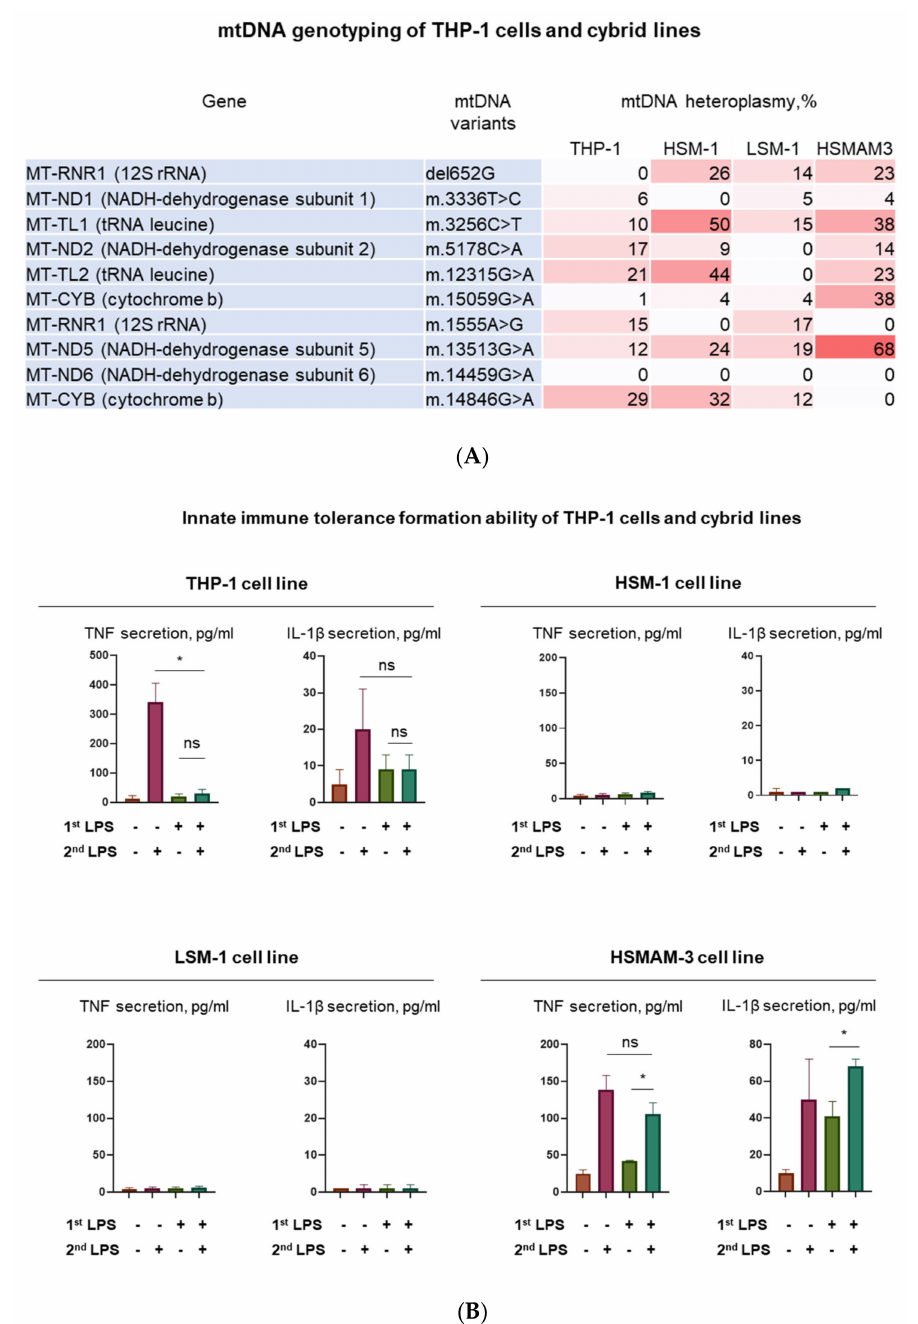
Figure 9. Ability of THP-1 cells and cybrid lines to form innate immune tolerance. ( A ) MtDNA genotyping of THP-1 cells and cybrid lines was performed and mtDNA heteroplasmy index was measured for 10 mtDNA mutations. ( B ) Innate immune tolerance formation ability of THP-1 cells and cybrid lines. First, 1 µ g / mL of lipopolysaccharides (LPS) was added to the cells cultured in suspension in RPMI medium (10% FBS) for 16 h (1st LPS). Then, cells were washed by sterile PBS and fresh RPMI medium with or without 1 µ g / mL of LPS was added for 4 h (2nd LPS). Finally, the secretion of tumor necrosis factor (TNF) and IL-1 β was evaluated by ELISA. A statistical analysis of the results of three independent experiments was carried out using the IBM SPSS Statistics 21 software package. The significance of p < 0.05 according to the results of t-test for paired samples is marked with an asterisk. Ns - no significance, i.e., p >